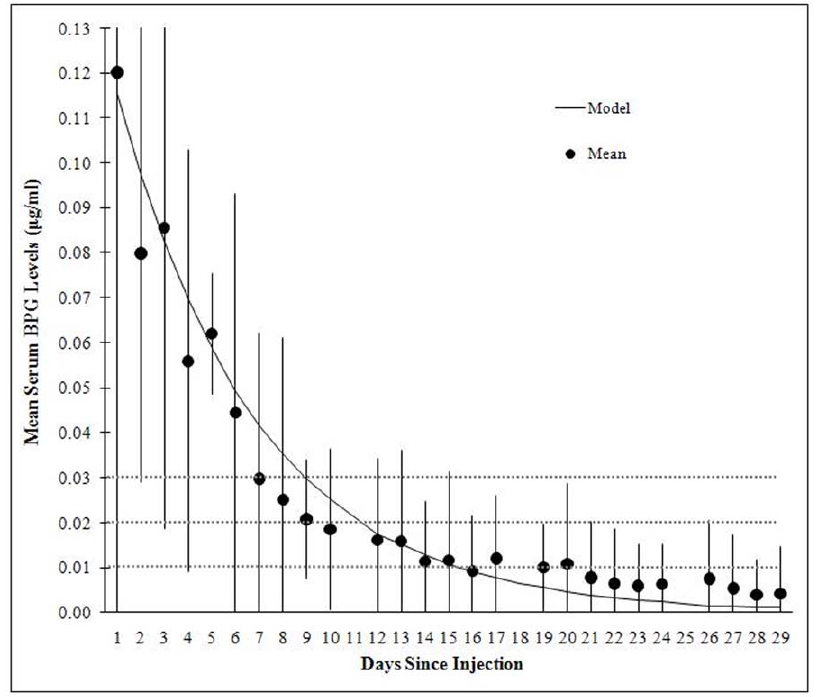
Figure 1. Mean BPG level and 95% confidence interval versus day since injection. Each subject provided a sample 1 day after injection and two more over the course of 28 days. The serum penicillin G half life is 4.1 days. At approximately day 11 the expected mean penicillin G serum level is less than 0.02 m g/ml. On days 1, 2 and 3 the 95% confidence intervals extend upward beyond 0.13 and are truncated to allow more visual resolution at the lower end of the curve. (Note: day 21 outlier removed from calculation of mean; see text.).